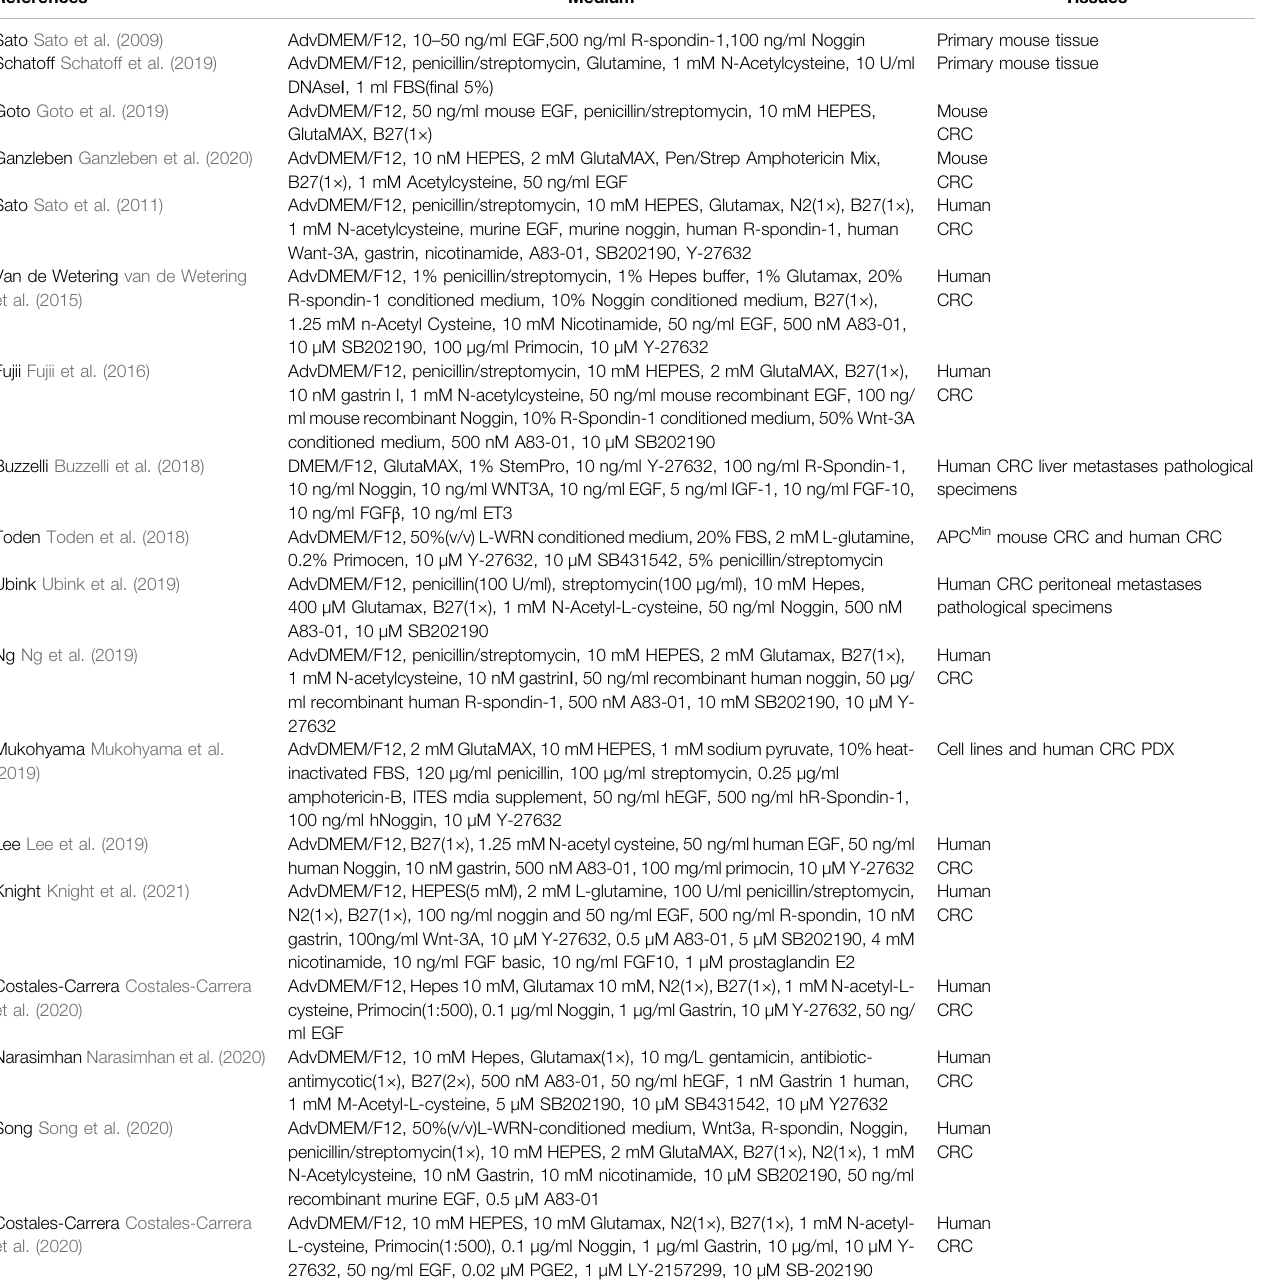
TABLE 1 | Summary of the different methods related to CRC organoids of mouse and